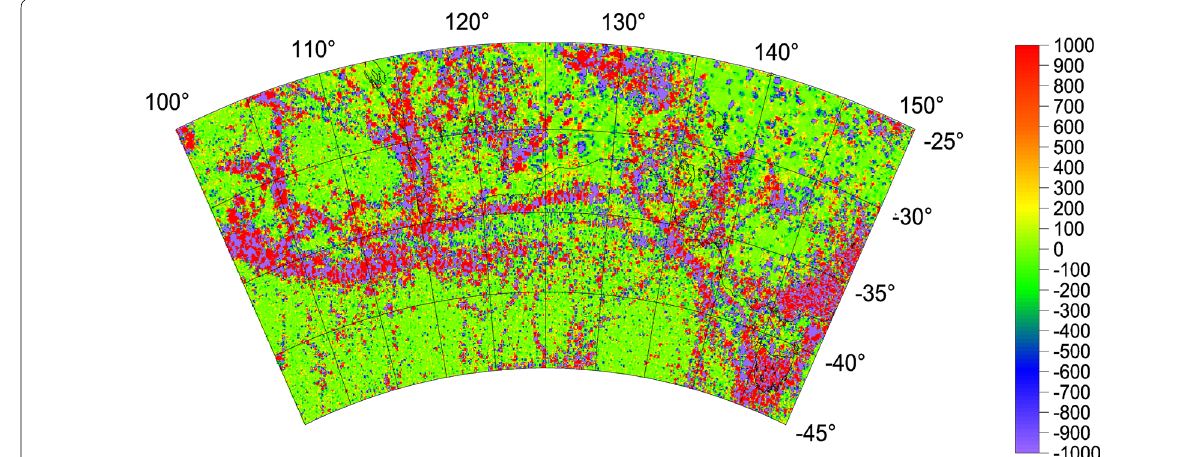
Fig. 17 I 2 [s − 6 ] for southern Australia with EIGEN 6C4